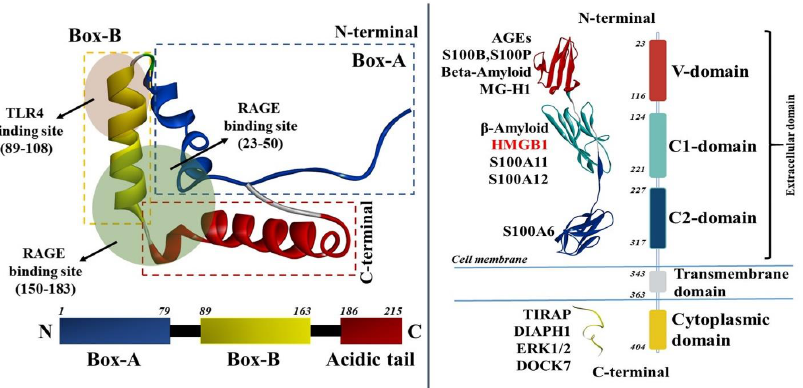
Figure 1. ( left ) Structure of HMGB1 and various ligand binding domains (PDB: 1HME); ( right ) Structure of full-length RAGE and various ligands that can bind to their respective binding domains (PDBs: 4LP5, 6VXG).